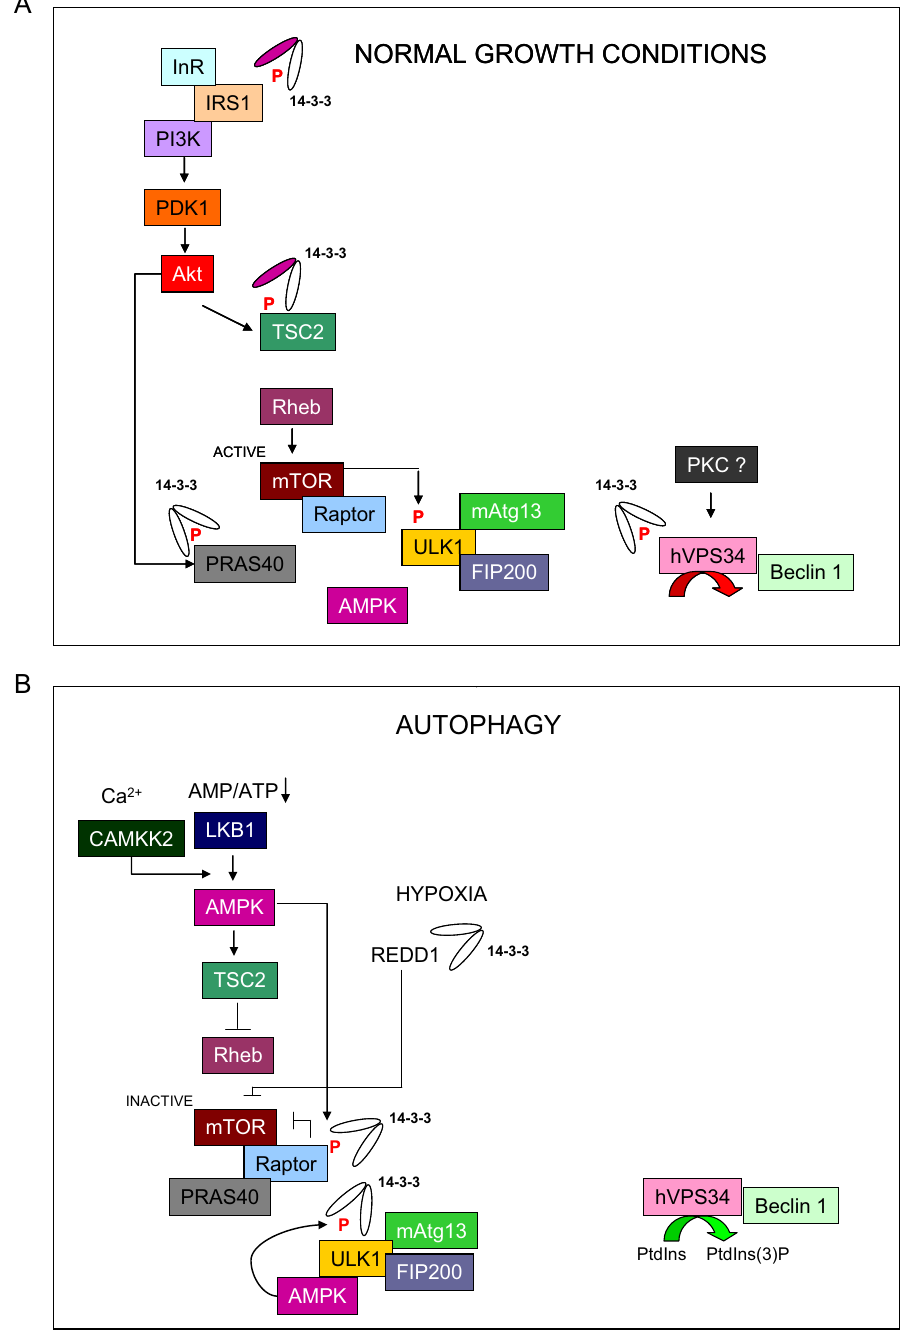
Figure 1. Model of 14-3-3 regulation on autophagy initiation process. (A) During normal growth conditions, 14-3-3 proteins bind and regulate TCS2, PRAS40 and hVps34 to block autophagy. (B) During nutrient starvation, 14-3-3 proteins bind to Raptor and ULK1 to promote the initiation of